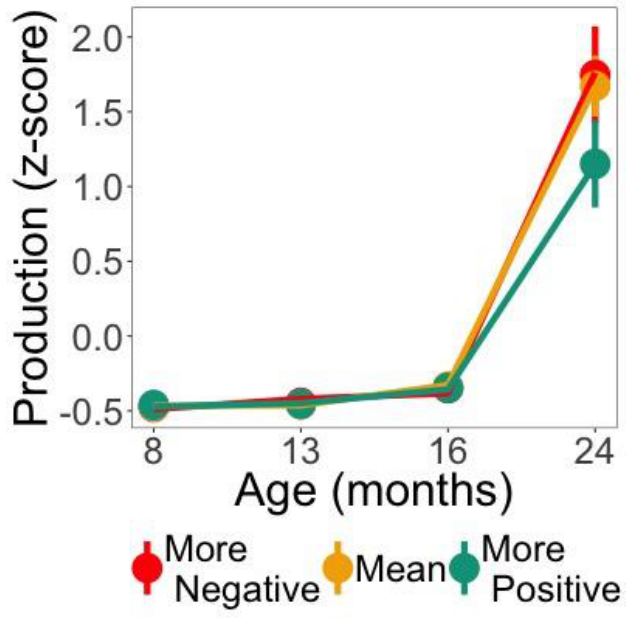
Figure 8. Total word production ( z -score) at the four ages measures (8, 13, 16, 24 months) as a function of the mispronunciation sensitivity difference score (target—mispronunciation) at eight months. Participants were grouped into whether this difference score was greater than 1 SD below the group mean (More Negative), within 1 SD of the mean (Mean), or greater than 1 SD above (More Positive). Note that these data groupings by mispronunciation difference score is merely for illustrative purposes, the predictor in the model was continuous. Lines indicate the fit of the model and whiskers indicate a standard error of 1.